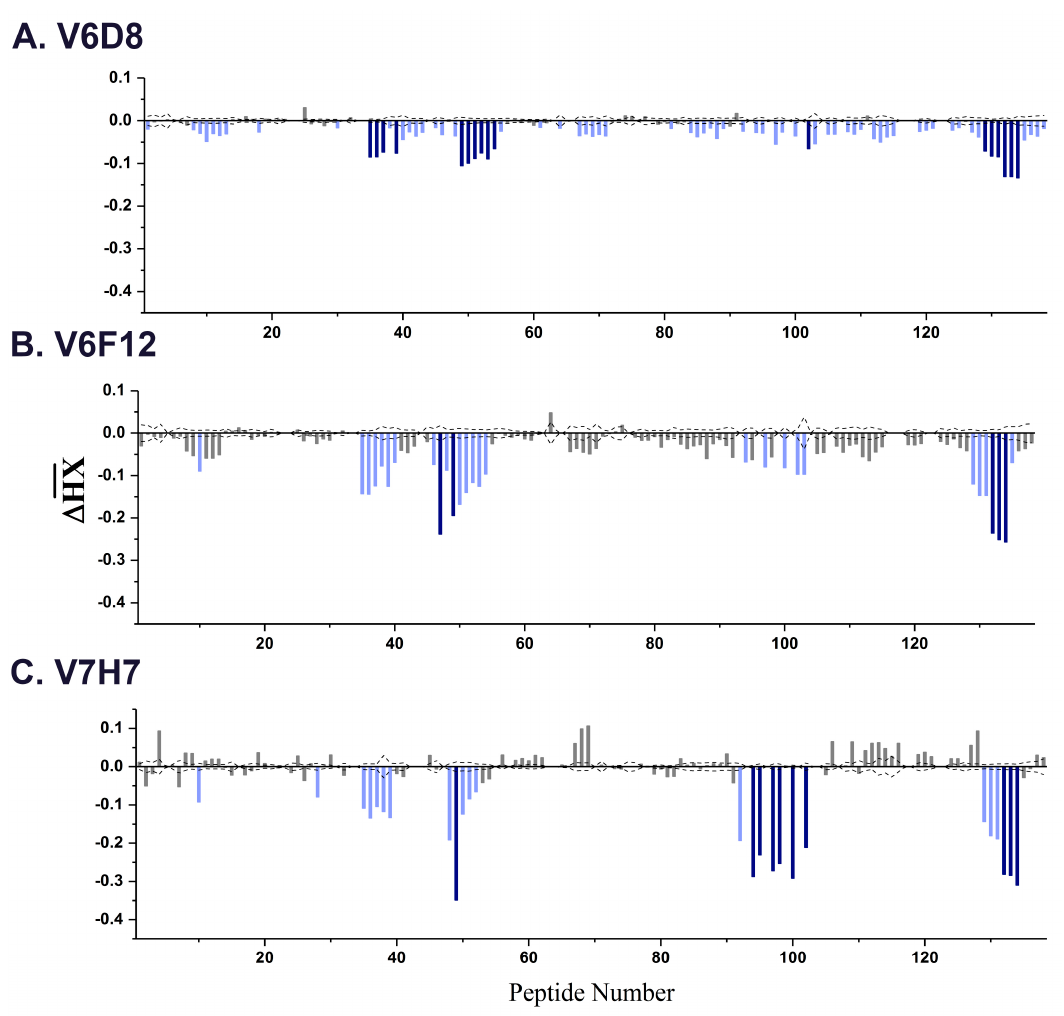
Figure 6. HX-MS analysis of RiVax bound to two V H Hs in subcluster 3.2. The ∆ HX values for each RiVax peptide are shown for V H Hs ( A ) V6D8 ( B ) V6F12 and ( C ) V7H7. The ∆ HX values are clustered using k-means clustering into three categories: strong (deep blue), intermediate (light blue) or no significant protection (gray). The dotted lines represent “3 σ ” confidence intervals for statistically significant changes in hydrogen exchange.